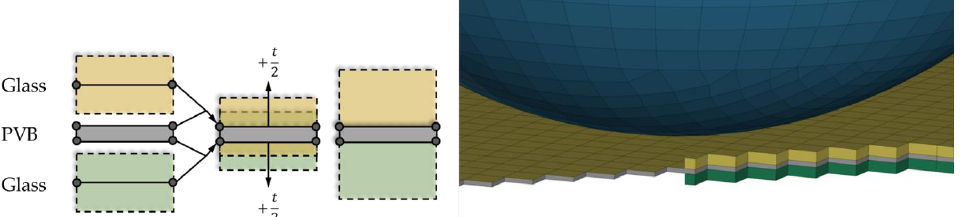
Figure 5. ( Left ) Modelling technique for laminated safety glass using a coincident nodes approach, ( right ) Visualization of the shifted shell thicknesses together with a part of the head impactor model.